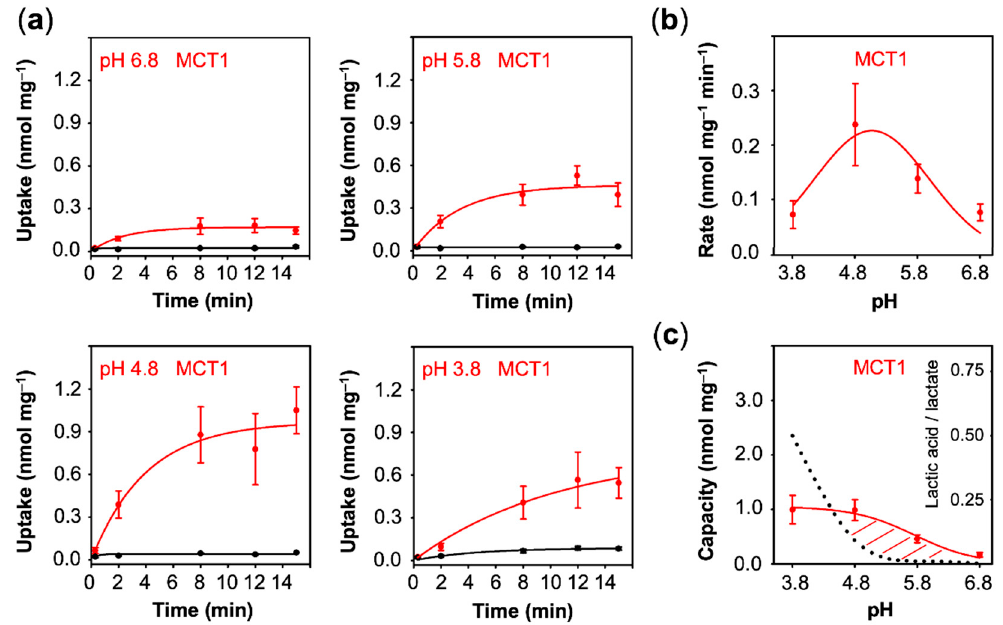
Figure 4. pH-dependent uptake of lactate / lactic acid into MCT1 expressing yeast. ( a ) Shown are uptake curves over time using cells with MCT1 (red) compared to non-expressing cells (black). ( b ) Uptake rates derived from the uptake curves. ( c ) Uptake capacity obtained from the plateaus of the uptake curves. The dotted line indicates the proportion of neutral lactic acid at a given pH condition. Error bars indicate SEM from three independent experiments.